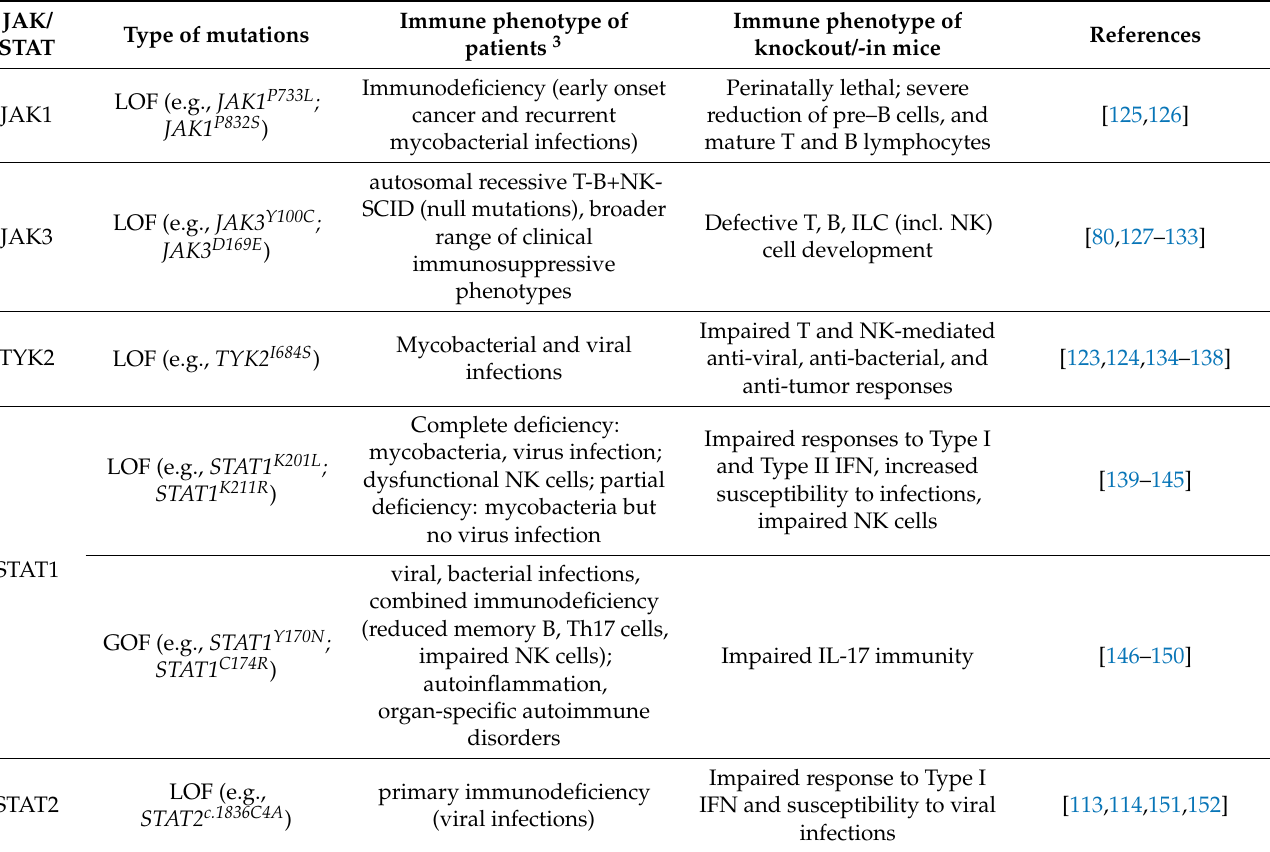
Table 3. Mutations in the JAK-STAT pathway resulting in patient’s immune dysfunctions and immunological phenotypes of respective knock-out/-in